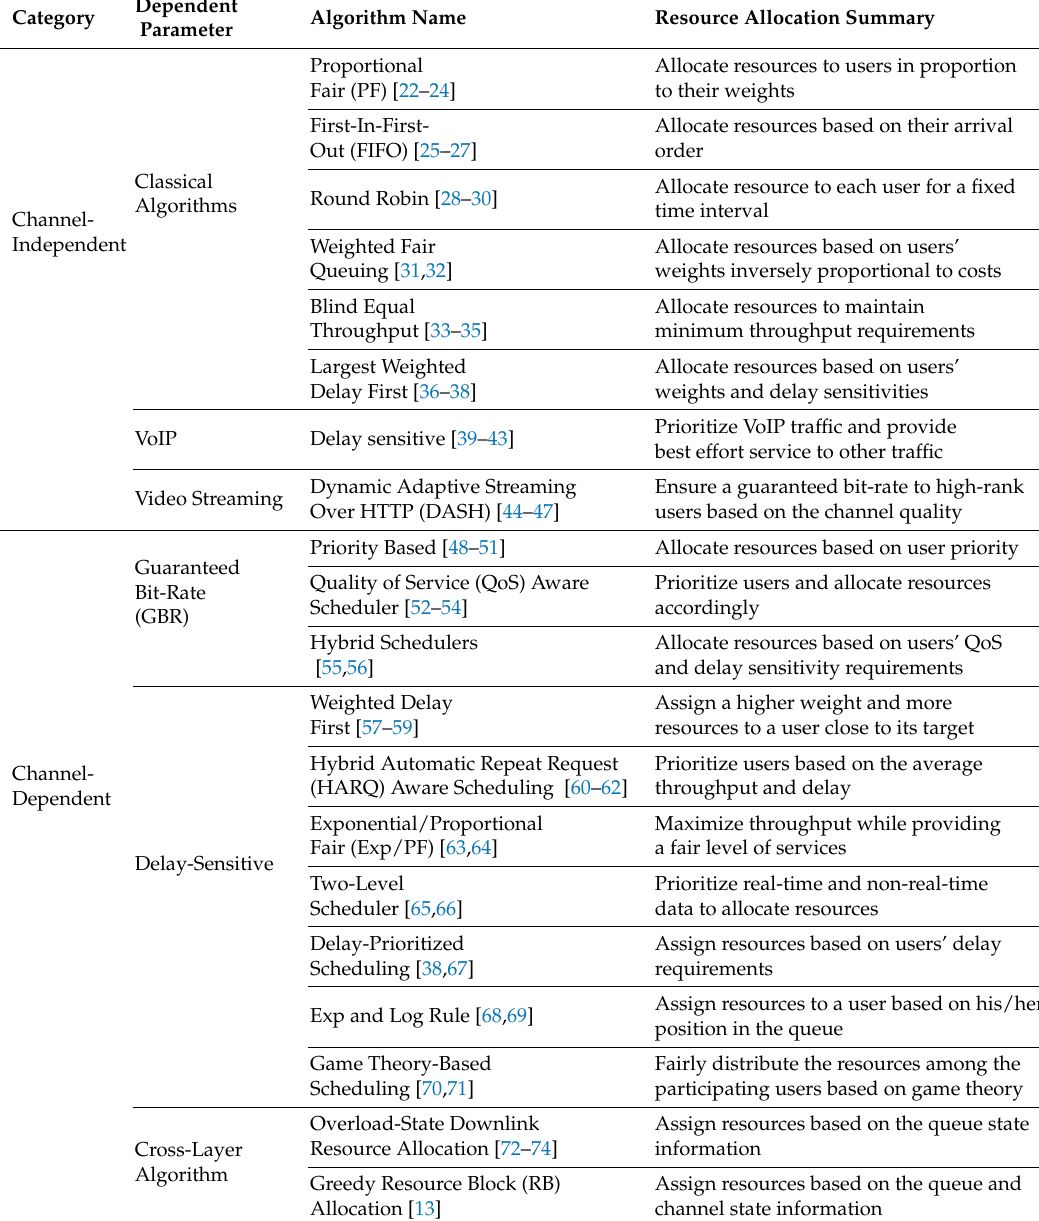
Table 1. Taxonomy of Scheduling and Resource Allocation (SRA)